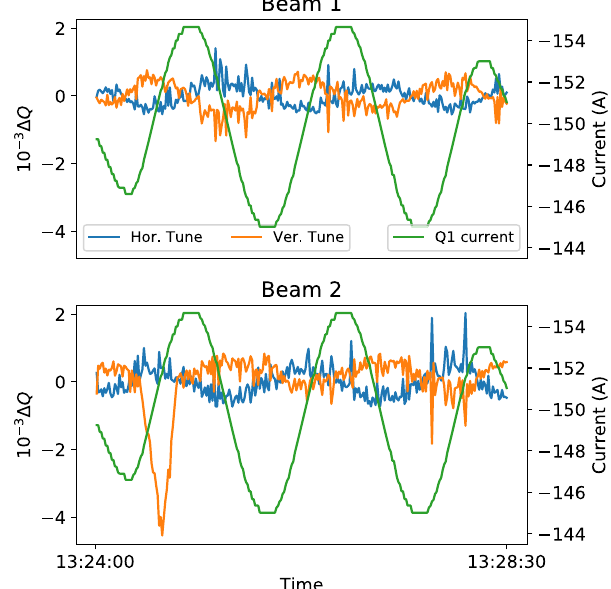
FIG. 8. K-modulation performed during ATS optics MD studies in 2016 with the tune feedback system enabled. A residual oscillation of about 10 − 3 remains uncompensated. Also the system reacted too late compensating the vertical tune in Beam 2, as can be seen in the start of the orange line in the bottom plot.